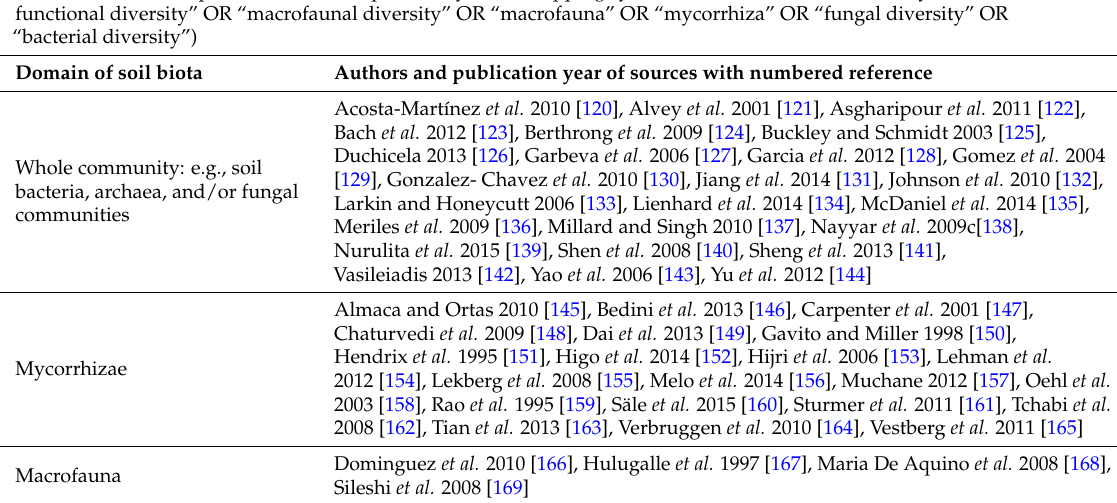
Table 2. Search terms and published sources ( N = 50) used to construct the meta-analysis of relationships between above-ground biodiversity and soil biotic communities. Sources are divided according to the domain of soil biota each research paper addressed. In addition to the search terms, backwards and forwards reference searches were used to more fully explore the